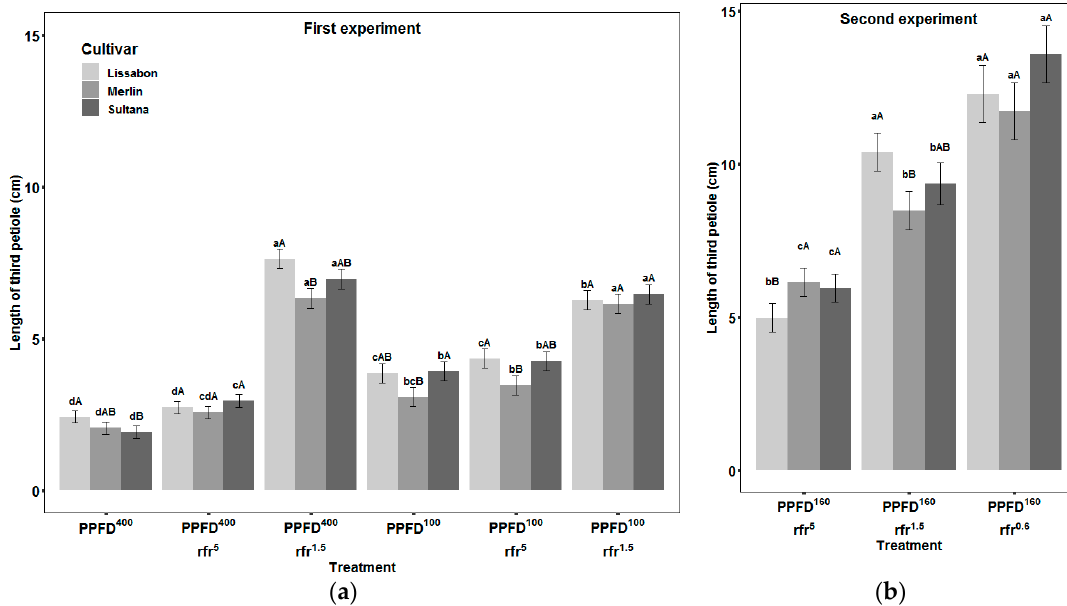
Figure 4. The least square means of third petiole length for the three cultivars in first ( a ) and second ( b ) experiment. Error bars indicate standard error of the LS-mean. For each experiment, lower case letters indicate significant differences between treatments for each cultivar, and upper case letters indicate significant differences between cultivars for each treatment ( p < 0.05). Table 5. The least square means of rachis length for the three cultivars in the first (top) and second (bottom) experiment. For each experiment, lower case letters indicate significant di ff erences between treatments for each cultivar, and upper case letters indicate significant di ff erences between cultivars for each treatment ( p <